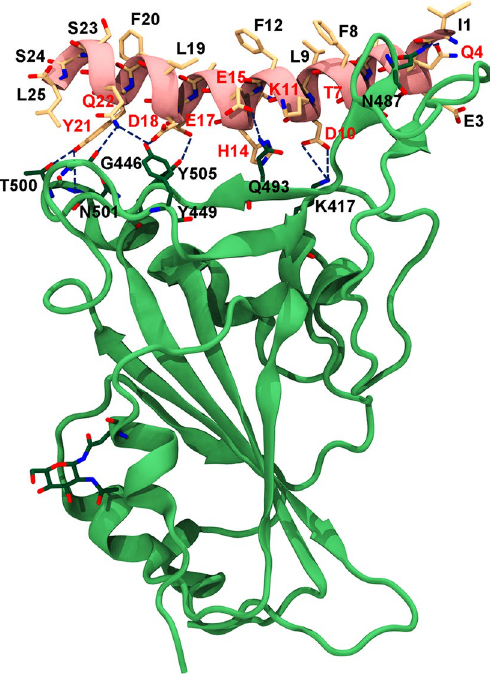
Figure 1. The structure of SPB25/SARS-CoV-2-RBD complex that was used as a design template. SPB25 and SARS-CoV-2-RBD are colored in pink and green, respectively. The designed positions (Q4, T7, D10, K11, H14, E15, E17, D18, Y21 and Q22) are labelled in